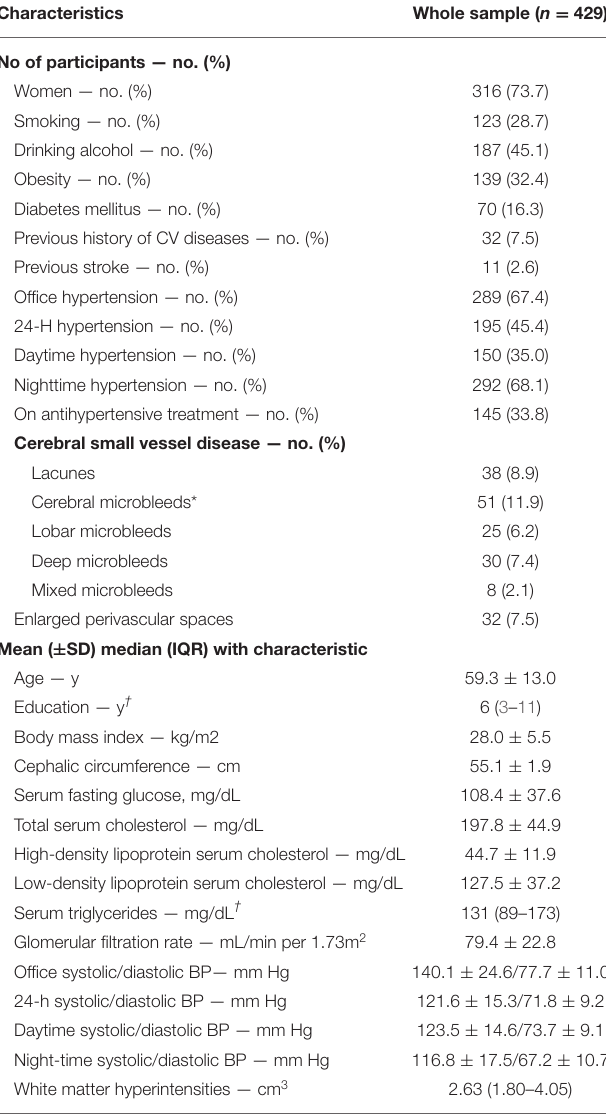
TABLE 1 | Baseline characteristics of the Maracaibo Aging Study participants with brain MRI